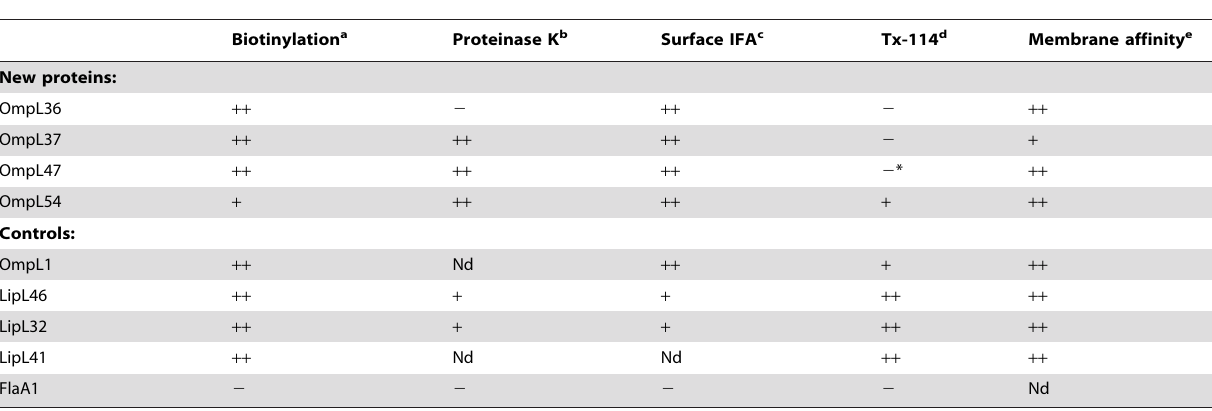
Table 2. Localization of outer membrane